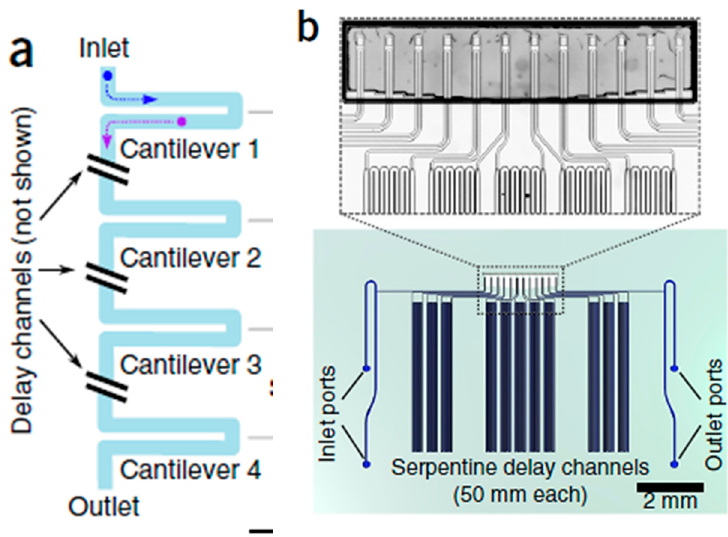
Figure 28. ( a ) Series of SMRs (cantilever mass sensors) separated by delay channels; ( b ) Rendering of a large channel serial SMR array device showing delay channels and the cantilevers (magnified in inset micrograph). Reprinted with permission from [196]. Copyright (2016) Springer Nature.